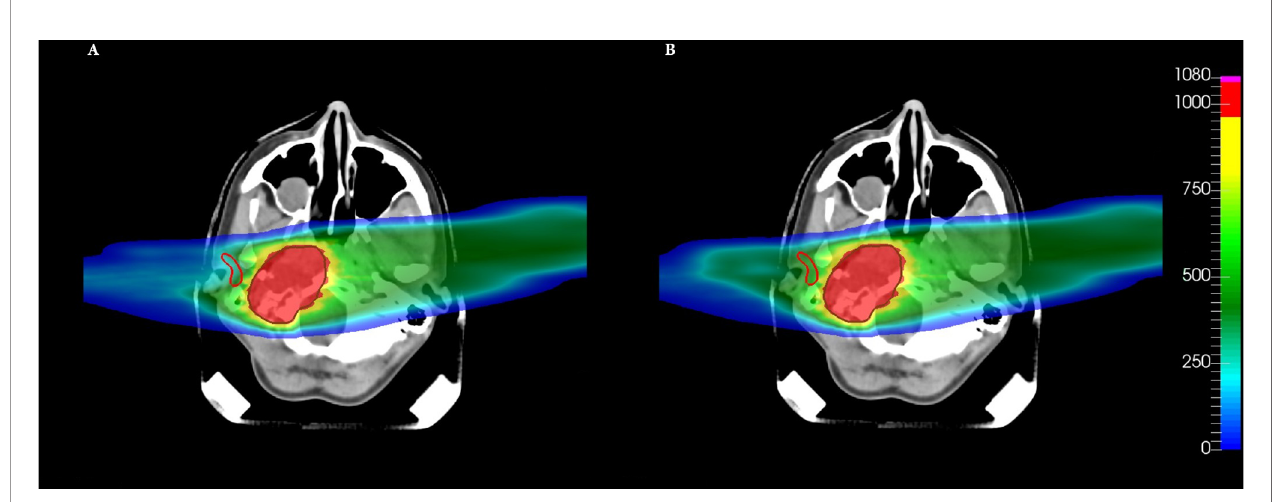
FIGURE 3 | Comparison of dose distributions on a CT slice for different volume effect parameters a of the parotid. Cost function parameters: (A) gEUD 0 = 0.50 Gy, a = 1 (red DVH in Figure 2B ). (B) gEUD 0 = 1.45 Gy, a = 10 (violet DVH in Figure 2B ). The target (brown contour) and the right parotid (red contour) are shown. The dose levels are plotted in per mil of the prescribed